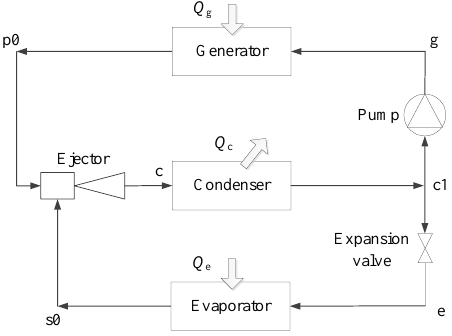
Figure 1. Equipments diagram for basic ejector refrigeration system.